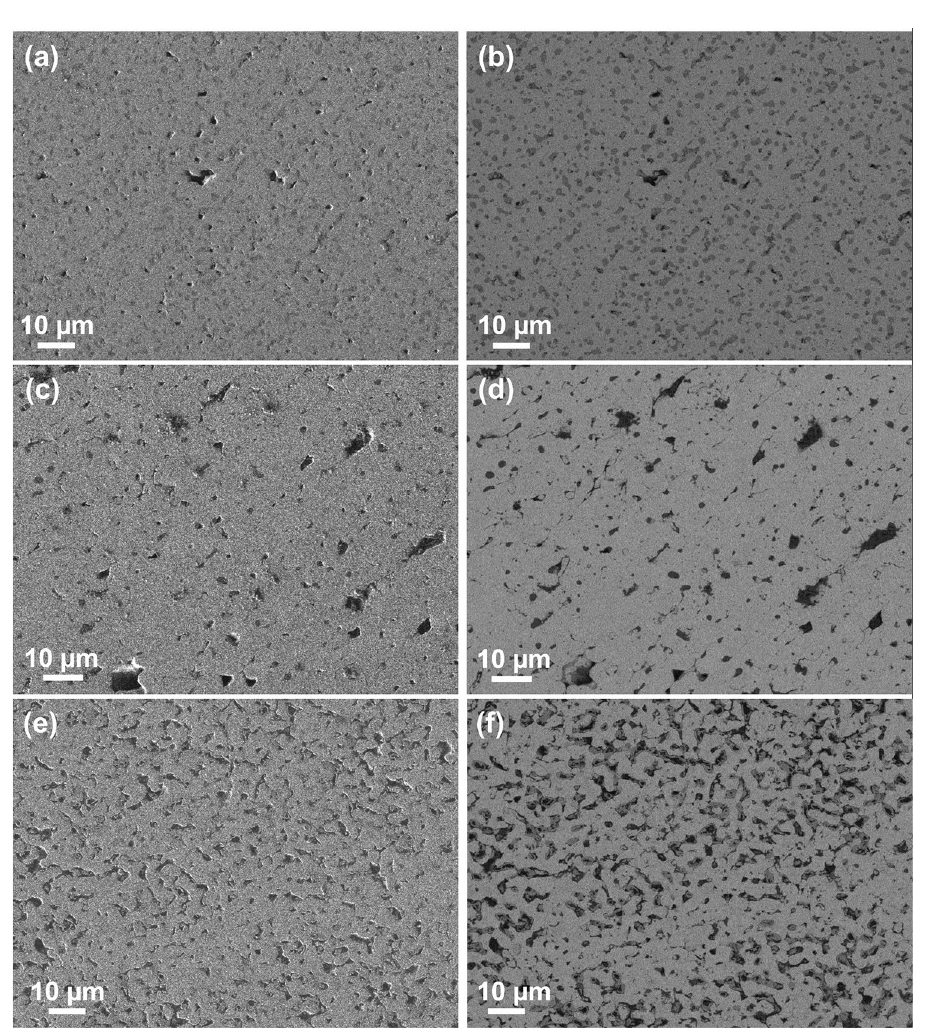
Figure 7. Secondary electron images and backscattered electron images of annealed ( a , b ) Fe 40 Co 20 Ni 40 , ( c , d )